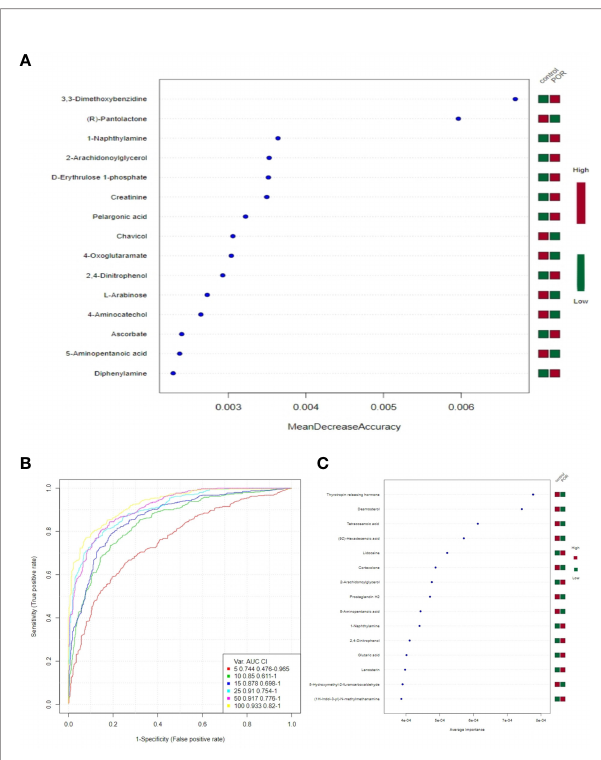
FIGURE 9 | 15 most important metabolites in random forest (A) , SVM ROC curve (B) , the 15 most important metabolites in SVM (C) . (A) The abscissa on the left is “ mean decrease accuracy ” , which measures the importance of a metabolite in random forest; on the right is a thermogram of the contents of the 15 metabolites in the two groups. (B) The abscissa is speci fi city and the ordinate is sensitivity. (C) The abscissa on the left is the average importance of SVM, and the heatmap on the right is the content of the 15 metabolites in the two